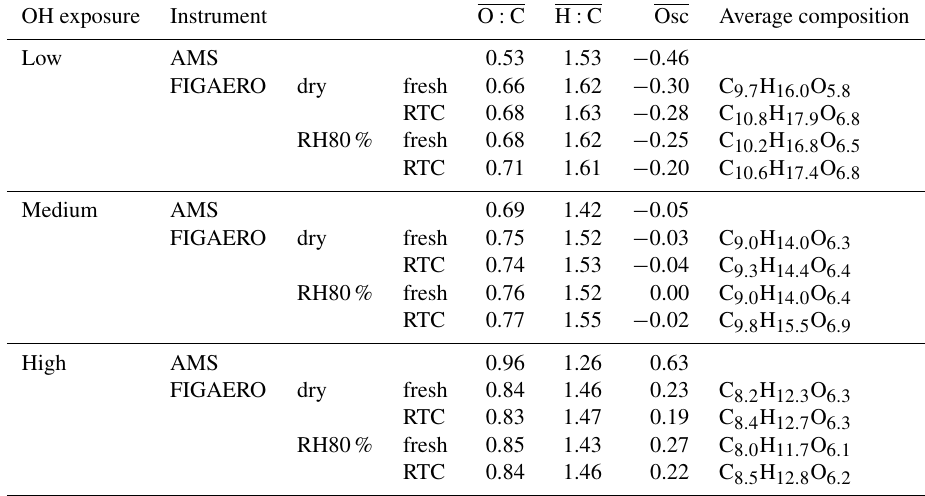
Table 1. Average oxidation state and average molecular formula derived from FIGAERO–CIMS and AMS measurements. OH exposure Instrument O : C H : C Osc Average composition Low AMS 0.53 FIGAERO dry